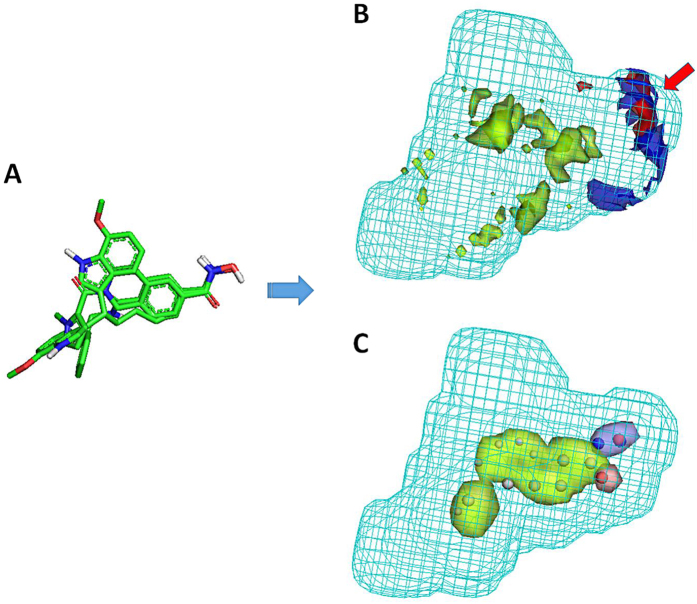
Pharmacophore model for selective HDAC6 inhibitors according to FLAPpharm.(A) Alignment obtained for the three compounds. (B) Pharmacophore obtained upon alignment in terms of common pharmacophoric interaction fields (PIFs). The hydrogen-bond donor constraint used for screening is indicated by a red arrow. (C) Pharmacophore obtained upon alignment in terms of common pharmacophoric points at the centroid of pseudoPIFs. The most relevant common pharmacophoric points at the centroid of the pseudoPIFs are also highlighted. For both pharmacophore depictions (B, C), the green areas represent the hydrophobic moieties, the blue areas represent the H-bond donor regions, the red areas represent the H-bond acceptor regions, and the cyan wireframe surface defines the shape of the pharmacophore.